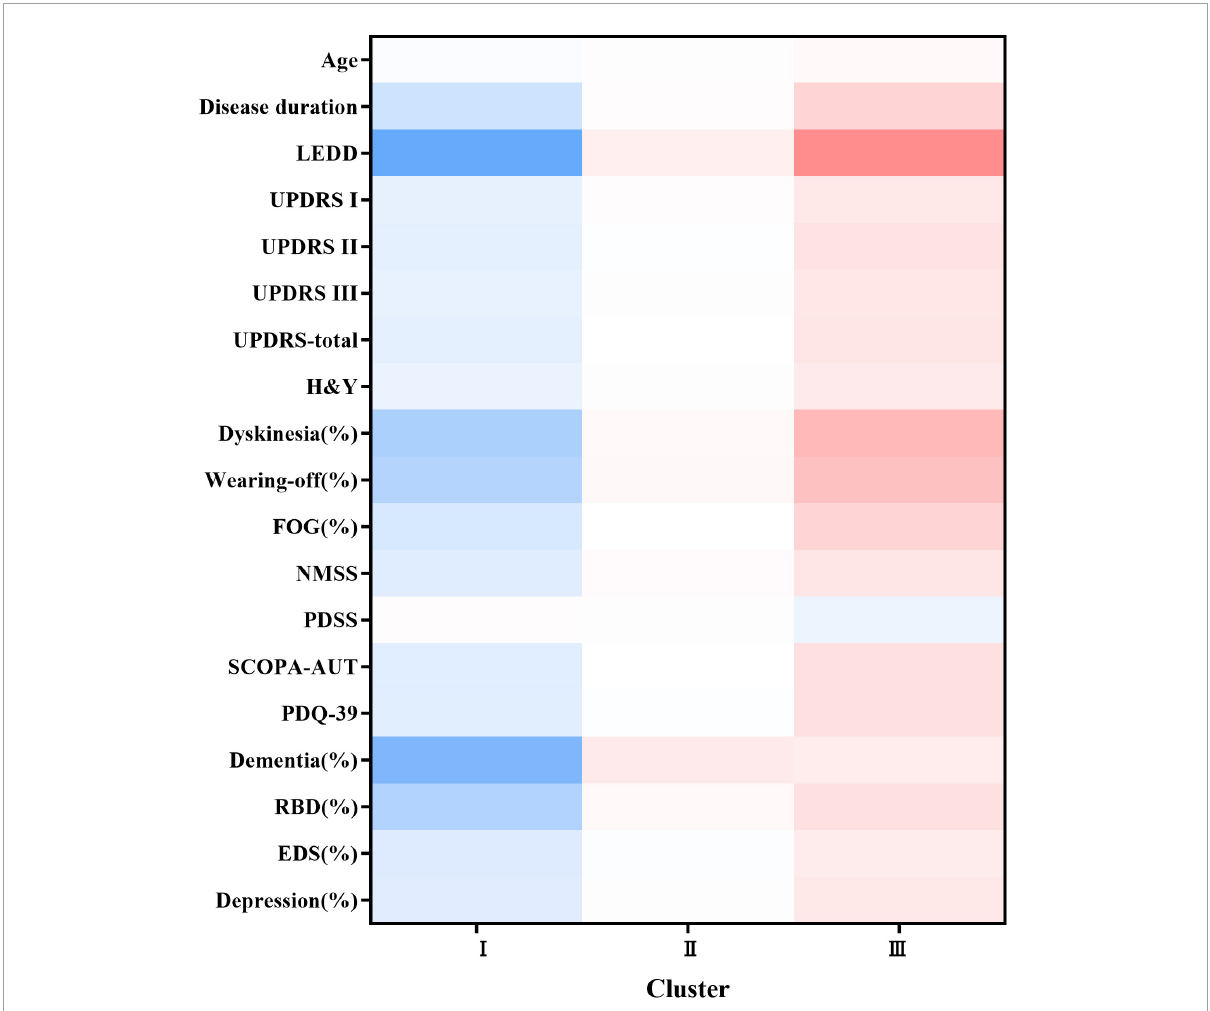
FIGURE1 Heatmap of the three subtypes at baseline. The figure was depicted according to the mean values or percentages of subtypes. The red color represented a more severe deficit and the blue color referred to a less severe symptom. The darker the figure described, the larger difference were shown among the subtypes. Variables with P value < 0.05 are shown. LEDD, Levodopa Equivalent Daily Dose; UPDRS, Unified Parkinson’s disease Rating Scale; H&Y, Hoehn and Yahr; FOG, freezing of gait; NMSS, Non-Motor Symptoms Scale; PDSS, Parkinson’s Disease Sleep Scale; SCOPA-AUT, the Scale for Outcomes in Parkinson’s Disease for Autonomic Dysfunction; PDQ-39, Parkinson’s disease questionnaire-39 item version; RBD, Rapid Eye Movement Sleep Behavior Disorder; EDS, excessive daytime